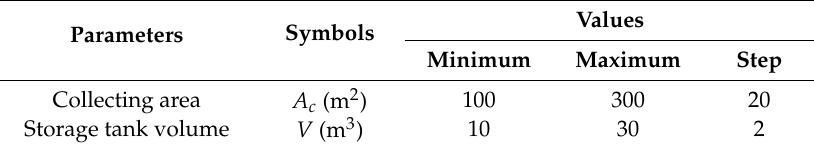
Table 3. Data about the optimization